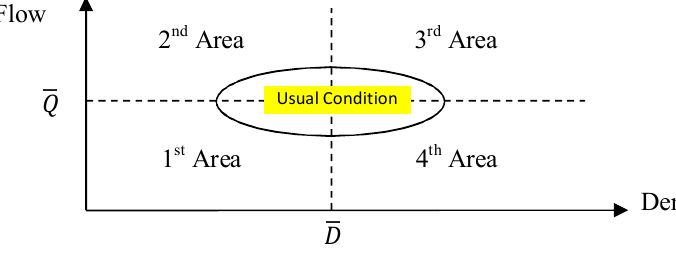
Fig. 1. Different conditions between Flow and